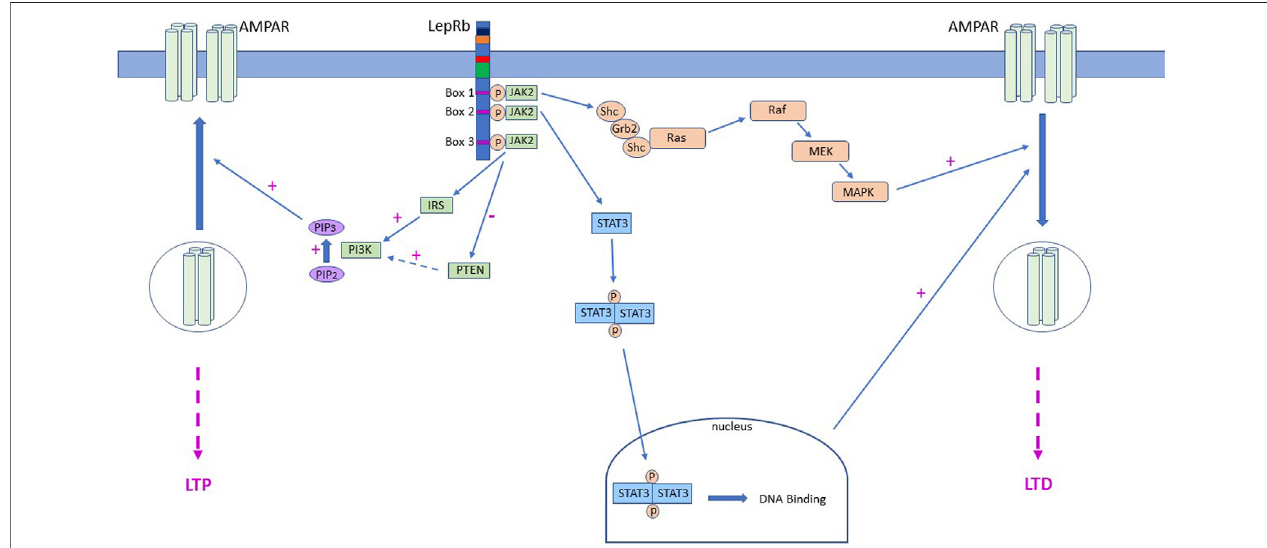
FIGURE1| LepRactivationdrivesalterationsinAMPAreceptortraf fi ckingviadifferentsignallingmechanisms.Schematicrepresentationofthesignallingcascades activated downstream of LepRs that contribute to movement of AMPA receptors (AMPAR) to and from hippocampal CA1 synapses. In juvenile tissue, LepR stimulation of Ras-RAF-MAPK (ERK) signalling and subsequent removal of AMPAR from synapses, leads to induction of Ltd. at SC-CA1 synapses. Leptin is also capable of stimulatingPI3Kactivitywhichincreases intracellular PIP3levelsanddrivesdeliveryofGluA2-lacking AMPAreceptors intoTA-CA1 synapses, resultingininduction ofLTP.Conversely,inadulthippocampus,LepRbactivationdrivesinhibitionofPTEN,whichinturnelevatesPIP3levelsandinsertionofGluA2-lackingAMPARsintoSC- CA1 synapses. In contrast, at adult TA-CA1 synapses, activation of LepRb stimulates canonical JAK2-STAT3 signalling which drives removal of synaptic AMPARs and subsequent LTD.